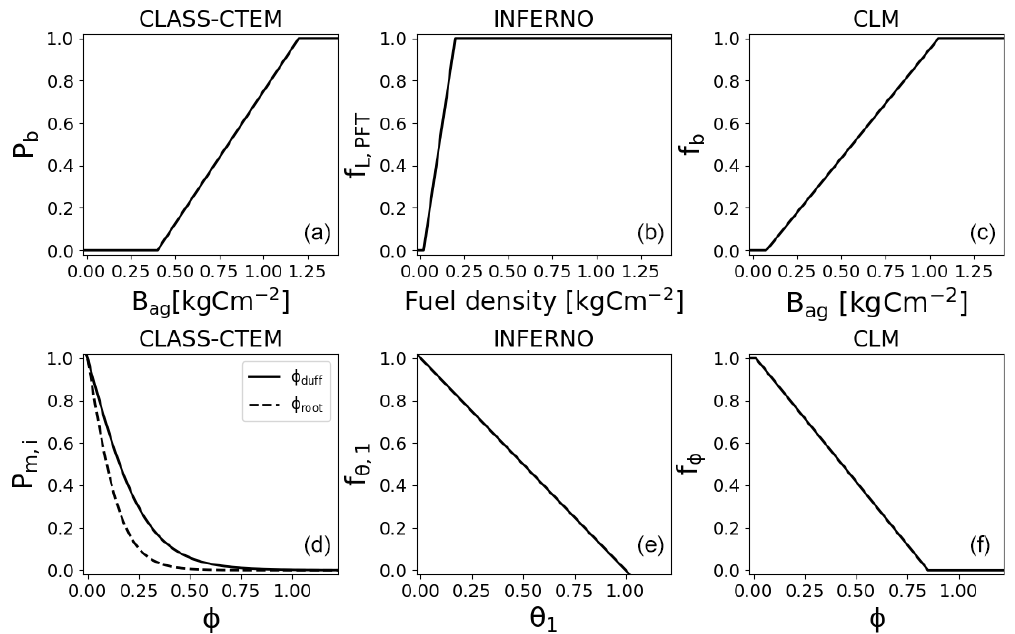
Figure 5. Impact of fuel load on fire for CLASS-CTEM, INFERNO and CLM. Impact of fuel load on the probability of fire ( P b ) for CLASS- CTEM, on the fuel load index ( f L , PFT ) for INFERNO and on fuel availability ( f b ) for CLM (a, b, c) . Impact of soil moisture content and soil wetness on fire for CLASS-CTEM, CLM and INFERNO (d, e, f) . In order to facilitate comparability, the soil moisture function for CLM is scaled to the value range